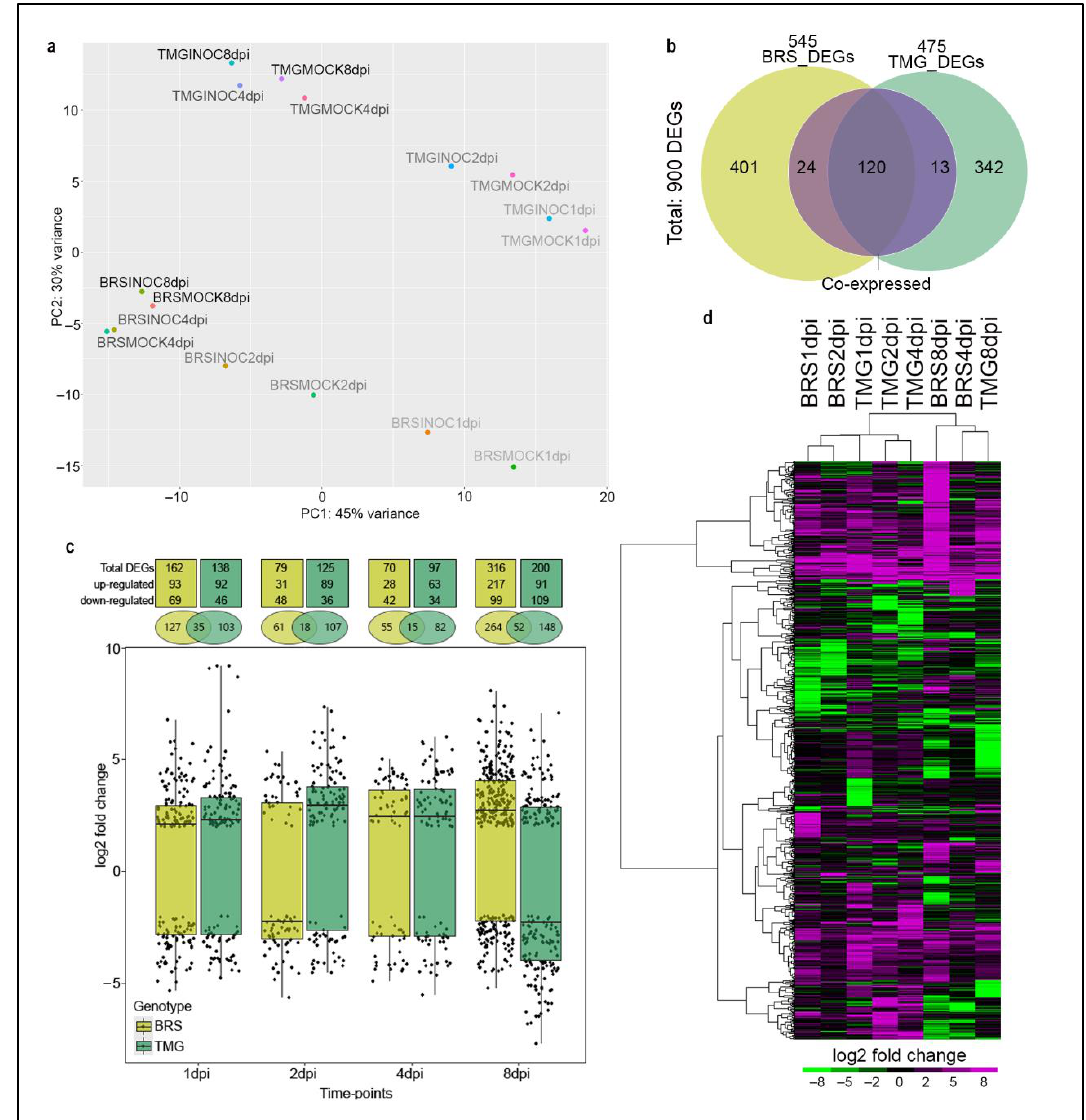
Figure 1. Overview of soybean DEGs in moderate resistance and susceptible response to RLNs. PCA of RNA-seq data with each color showing clear genotype, time-point, and treatment (infected and non-infected), where treatment is the differentiating factor among samples ( a ). Venn diagram showing unique and shared differentially expressed genes (DEGs) in BRS and TMG as common expressed genes under RLN infection, from left to right: (yellow) is DEGs exclusive to BRS = 401; (yellow + purple) is DEGs exclusive to BRS found in more than one time point = 24, (yellow + purple + green) is DEGs found in BRS and TMG, that could also have been expressed in more than one time point in each = 120; (green + purple) is DEGs exclusive to TMG found in more than one time point = 13; and (green) is DEGs exclusive to TMG = 342. ( b ). Boxplot with numbers of common expressed genes, up and down-regulated DEGs in BRS and TMG in response to RLN at 1, 2, 4, and 8 dpi ( c ). Hierarchical clustering of DEGs at each genotype/time-point ( d ).